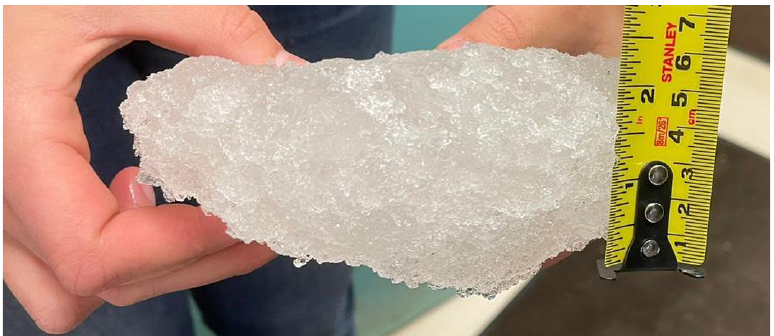
Figure 4. Sample of 5 cm-thick ice.